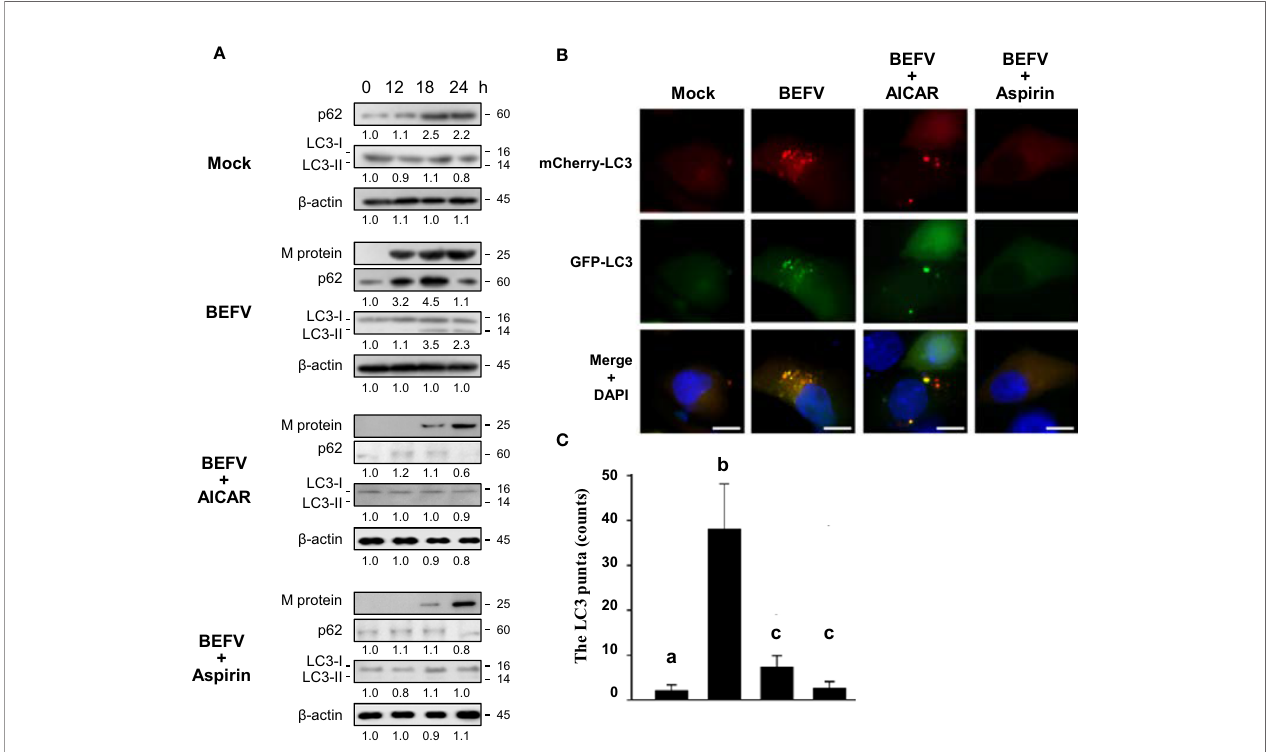
FIGURE 7 | Delayed autophagosome formation by BEFV is suppressed by 5-aminoimidazole-4-carboxamide-1- b -riboside (AICAR) or aspirin. (A) MDBK cells were infected with BEFV at an MOI of 1 with or without pretreatment of AICAR (1 mM) and aspirin (5 mM), respectively. Cell lysates were collected at the indicated time points and subjected to immunoblotting with the respective antibodies. The levels of indicated proteins in the mock group were considered onefold. The activation and inactivation folds indicated below each lane were normalized against values for the mock control group. b ‐ actin was used for the internal control for normalization. All experiments were conducted in three independent experiments. Signals in all Western blots were quanti fi ed with ImageJ software. The predicted size of each protein was labeled at the right-hand side in kDa. (B) Induction of autophagy in MDBK cells expressing the mCherry-GFP-LC3 protein was monitored after pretreatment with AICAR or aspirin, respectively, for 30 min and then infected with BEFV at an MOI of 1 for 18 h. LC3 fl uorescent puncta were observed using fl uorescence microscopy. Cell nuclei were stained with DAPI. Scale bars, 25 mm. (C) The numbers of LC3 punta were calculated from the results from panel (B) . Signi fi cance between the treatments was determined by Duncan ’ s Multiple Range Test (MDRT) using SPSS software (Version 20.0). Means with common alphabets (a, b, c) denotes no signi fi cance at p <0.05. Each value represents mean ± SE of three independent